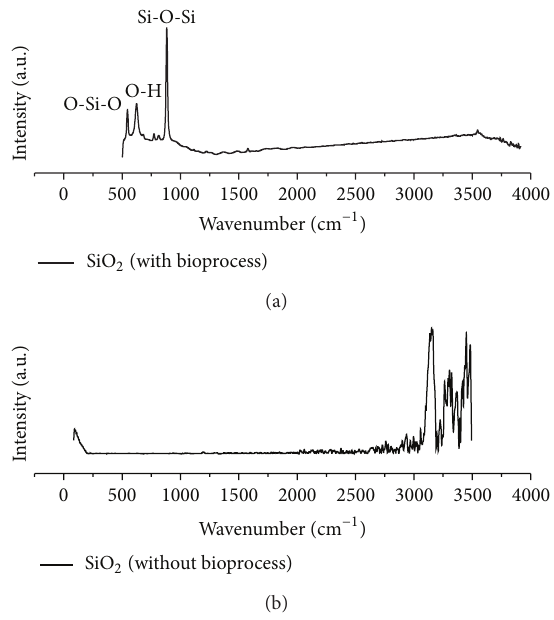
Figure 2: FT-Raman spectra of silica particles obtained for annelids bioprocess (a) and without bioprocess